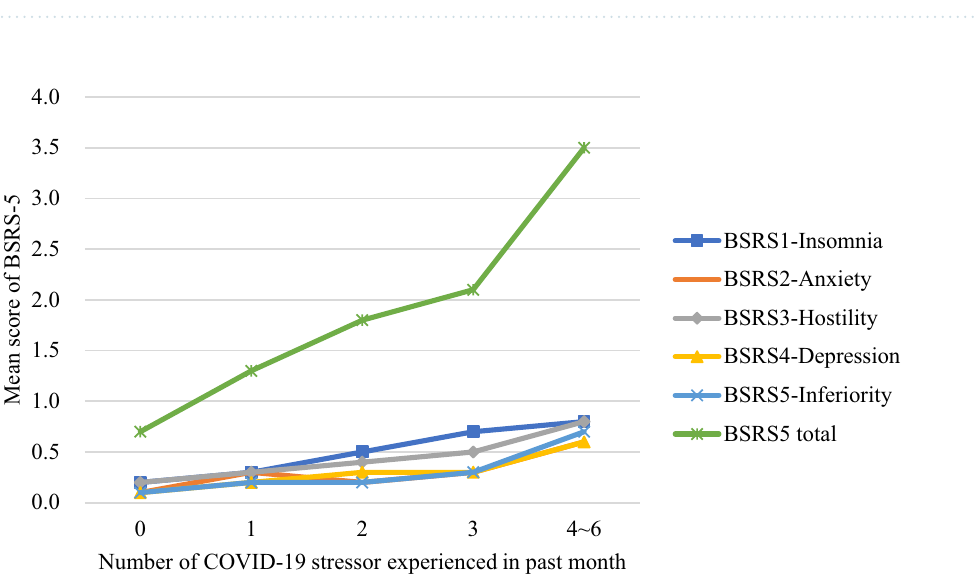
Table 2. The odds of COVID-19 stress by suicidality, psychiatric morbidity and psychosocial variables. All the above-mentioned data were weighted; missing data were excluded for analysis. BSRS-5: The Five-item Brief Symptom Rating Scale; OR: odds ratio; CI: confidence interval.